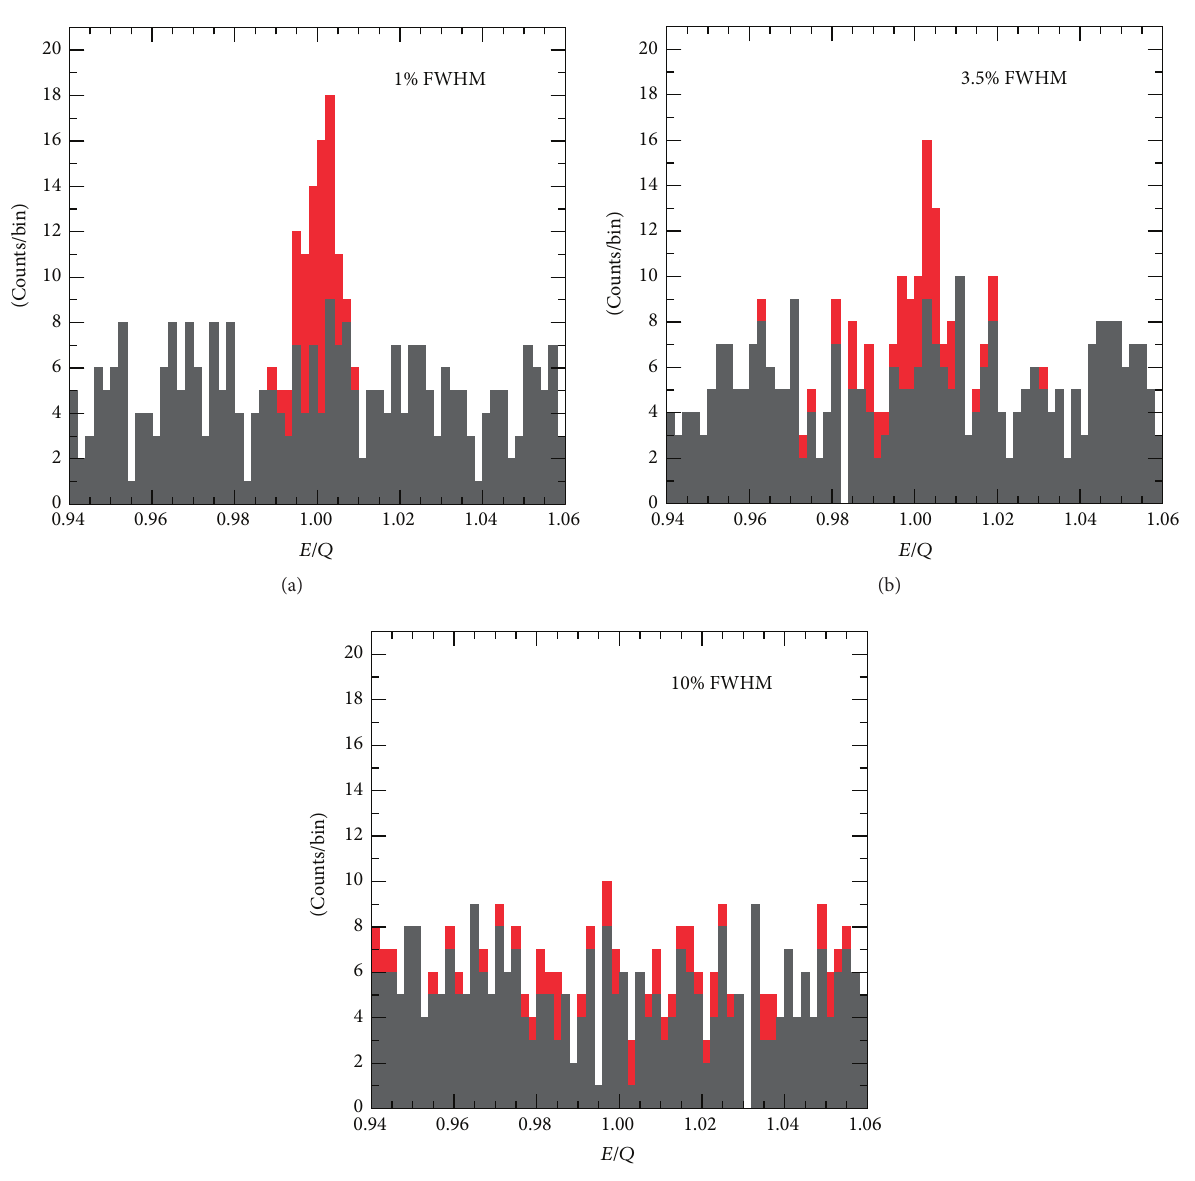
Figure15:Signalandbackground(redandgraystackedhistograms,resp.,)intheregionofinterestaround 𝑄 𝛽𝛽 for3MonteCarloexperiments with the same signal strength (50 counts) and background rate (1 count keV −1 ), but different energy resolution: (a) 1% FWHM; (b) 3.5% FWHM; (c) 10% FWHM. The signal is distributed normally around 𝑄 𝛽𝛽 , while the background is assumed flat. Figure from